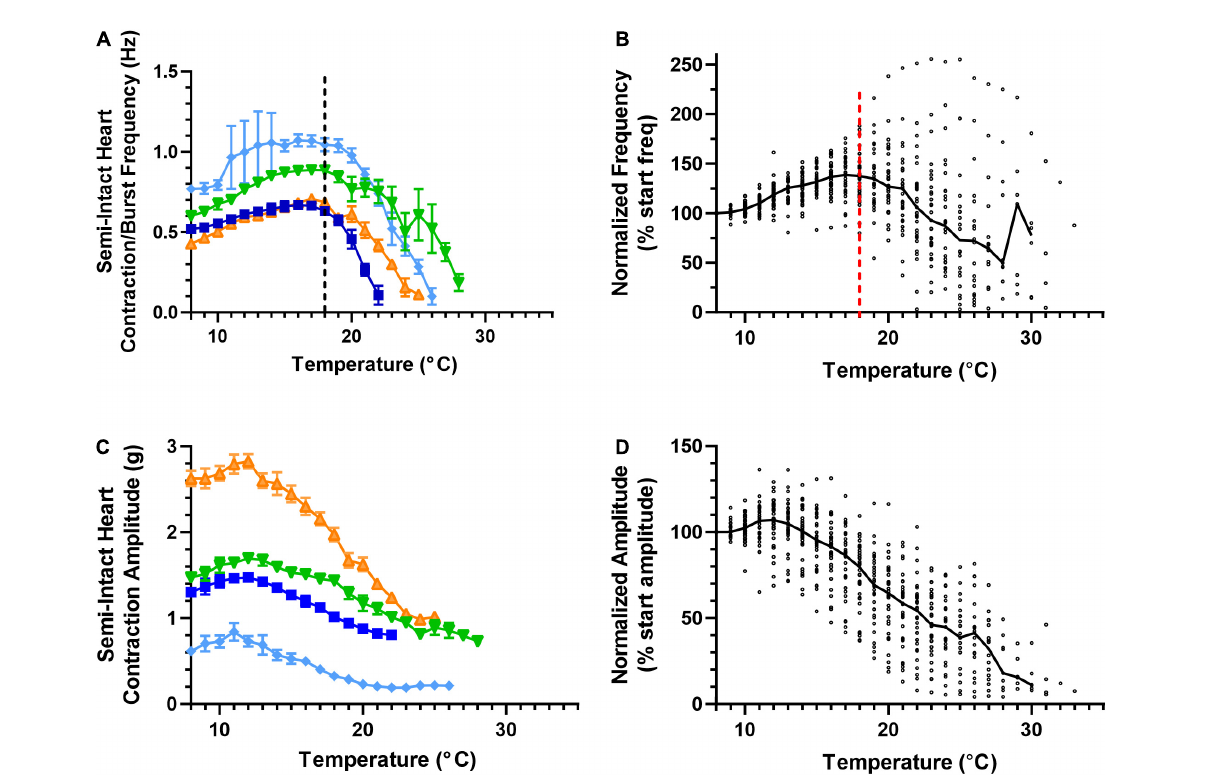
FIGURE3 Cardiac neuromuscular system responses to an increasing temperature ramp: contraction frequency and amplitude. Values show data averaged in 1 ◦ C bins, with the data plotted at the center of each bin. (A) A plot of heart contraction frequency in response to a temperature ramp from 8 ◦ C to crash temperature for four semi-intact preparations (each shown in a different color). Note that at ∼ 18 ◦ C (dashed line), contraction frequency began to decrease in each of these example preparations. (B) A plot of heart contraction frequency normalized to the contraction frequency at 8 ◦ C in response to a temperature ramp from 8 ◦ C to crash temperature for all semi-intact preparations. ( N = 35 until the first preparation crashes at 19 ◦ C; N decreases from that temperature on). (C) Plot showing contraction amplitude (force, grams) as a function of temperature for the same four semi-intact preparations plotted in panel (A) . Note that contraction amplitude decreased as temperature was increased above ∼ 12 ◦ C. (D) A plot of contraction amplitude as a function of temperature, with the contraction amplitude for each preparation at each temperature step normalized to the contraction amplitude at 8 ◦ C ( N = 35 until the first preparation crashes at 19 ◦ C; N decreases from that temperature on). All data points in panels (A,C) show the mean ± SD for a given parameter at each temperature step. In panels (B,D) , the solid back line connects median normalized contraction frequency and amplitude, respectively, at each temperature step. Medians are omitted when N ≤